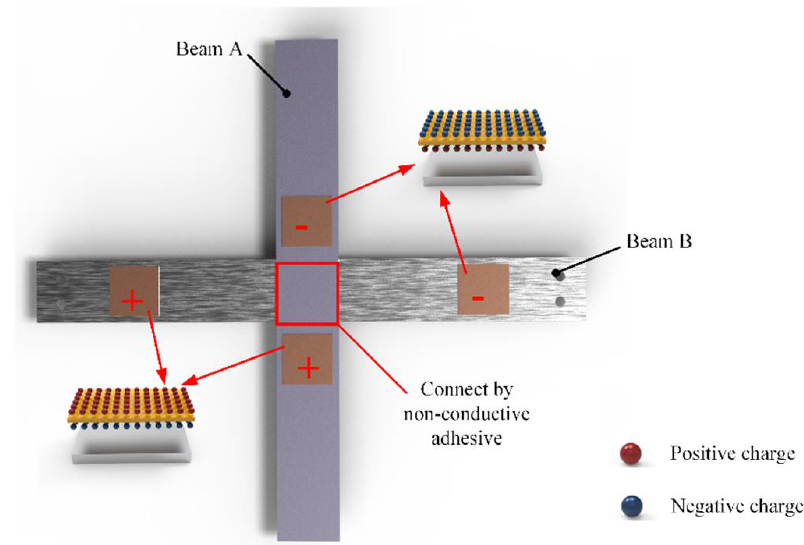
Figure 2. The connection style of the energy